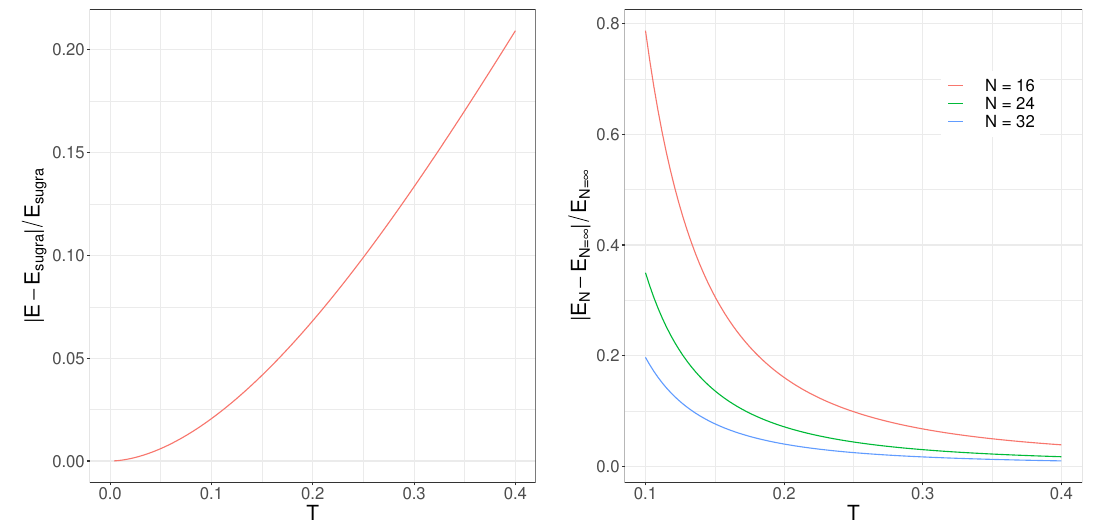
Figure 7 . [Left] Relative size of the α 0 -corrections in the BFSS model as a function of T . [Right] Relative size of the 1 /N 2 term in equation (3.27) to the BFSS energy as a function of T for various N